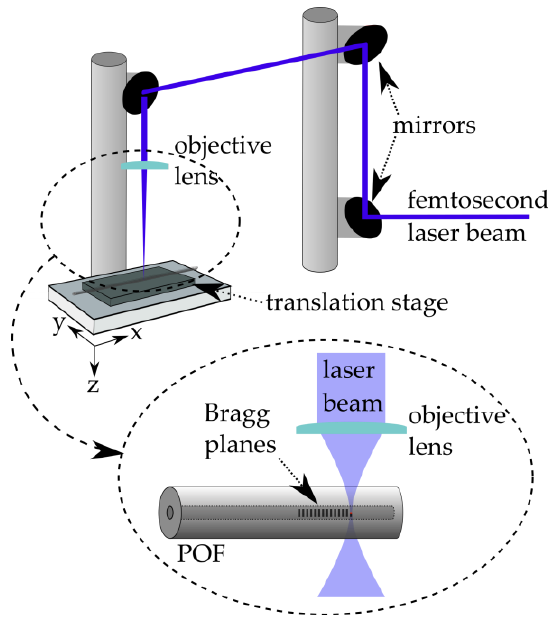
Figure 1. Setup for the fabrication of POFBG sensors.